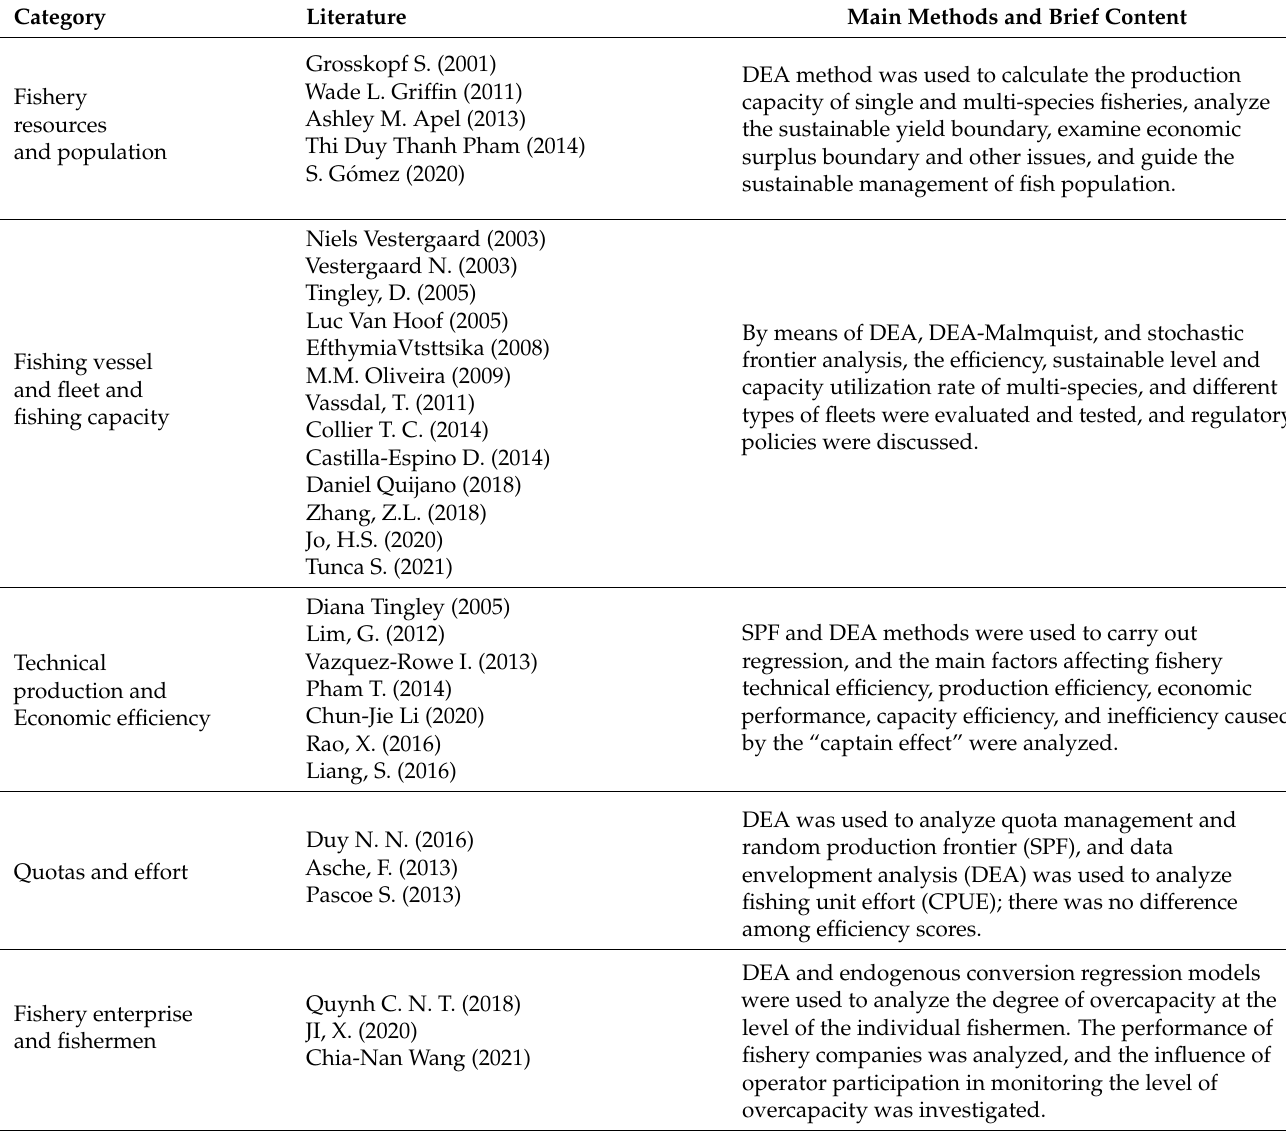
Table 1. Literature